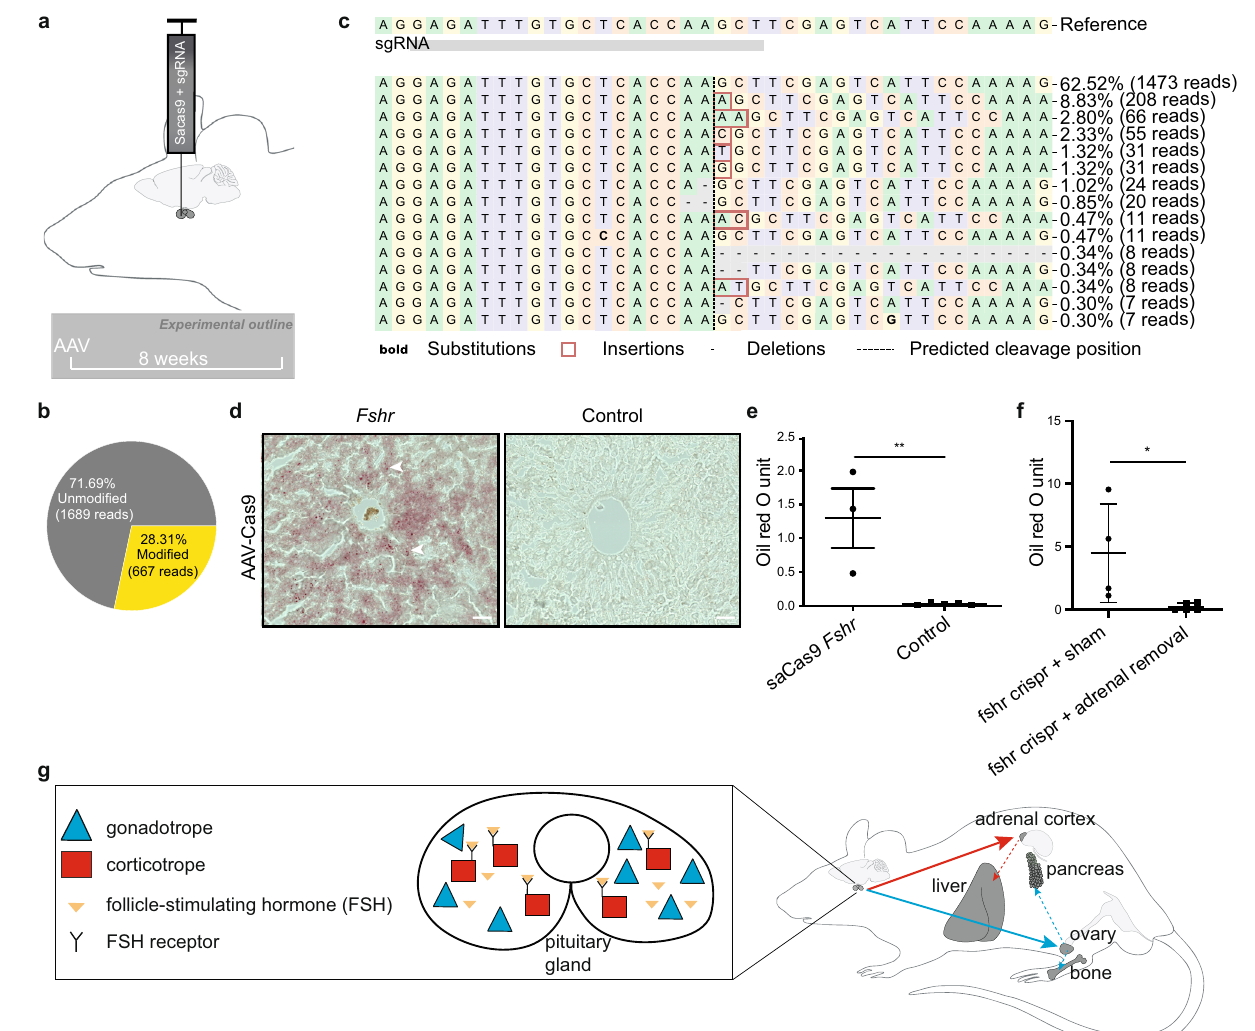
Fig. 6 | FSH receptor knock-out in the pituitary induces hepatic steatosis in females. a Illustration depicting the strategy to speci fi cally disrupt FSH receptor expression in the pituitary via stereotaxic delivery of an adeno-associated virus (AAV) encoding Cas9 and a guide RNA targeting Fshr into the pituitary. b Percentage of unmodi fi ed and modi fi ed alleles and c distribution of identi fi ed alleles around the predicted cleavage site determined by CRISPResso2 of the pituitary DNA from an AAV5-saCas9- Fshr injected mouse. d Representative images (scale bars = 50 μ m) and e quanti fi cation of liver oil red O staining from AAV-Cas9 (with ( n =3 mice) or without ( n =5 mice) guide RNA against follicle-stimulating hormone receptor; Fshr) pituitary-injected mice. f Liver oil red O staining